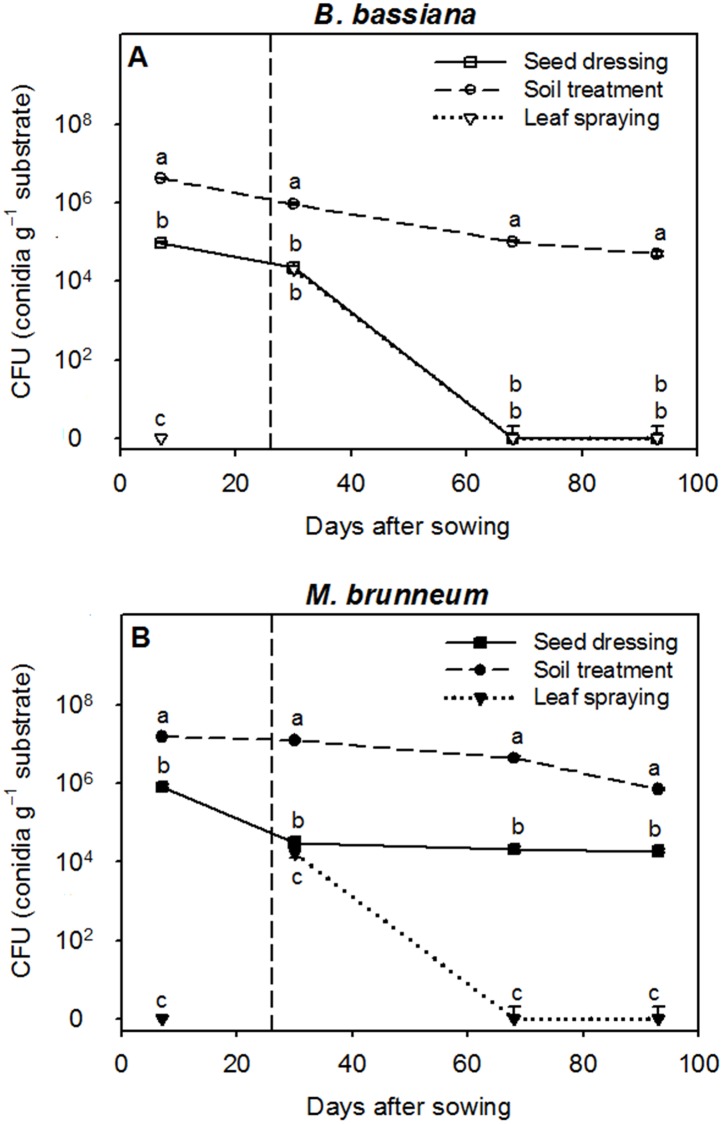
Colony-forming units (CFU).The number of conidia g-1 in the calcareous substrate (mean ± standard error, n = 4) for each fungal strain as a function of the inoculation method (seed dressing, soil treatment and leaf spraying) at 7, 30, 68 and 93 days after sowing (DAS). The dashed line indicates the time of application of the leaf treatment. No B. bassiana or M. brunneum CFUs were detected in the substrate samples from the control pots. Different letters indicate significant differences between inoculation methods in each sampling according to the LSD post hoc test at p < 0.05.